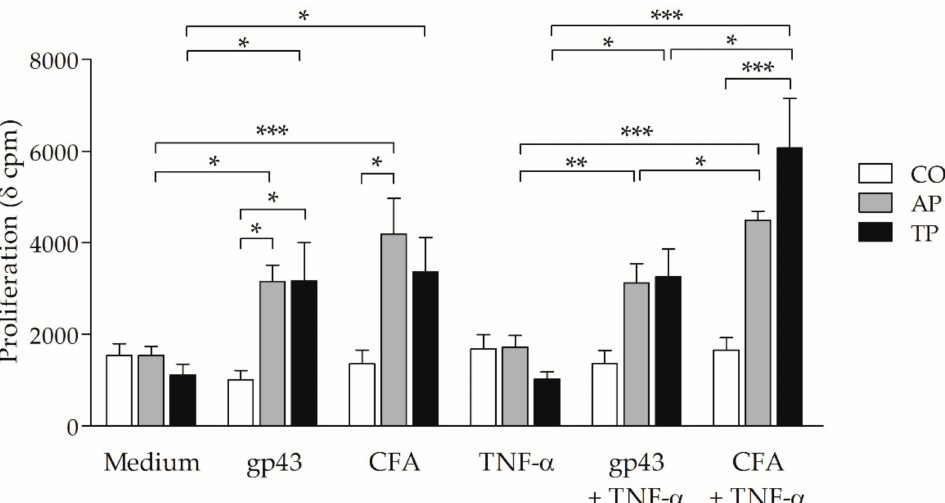
Figure 5. Influence of gp43- and CFA-stimulated moDCs on the proliferative response of autologous lymphocytes: proliferation levels measured by [ 3 H]-thymidine uptake on cocultures of autologous lymphocytes and moDCs from non-PCM control subjects (CO: white bars; n = 15), and patients with active PCM (AP: grey bars; n = 17) or treated PCM (TP: black bars; n = 22) previously stimulated with gp43 or CFA, with or without TNF- α , or left untreated (Medium), after 120 h. Results expressed as means with SEM of δ cpm, and capped lines indicate statistically significant differences with respective p values: * p < 0.05, ** p < 0.01, or *** p <